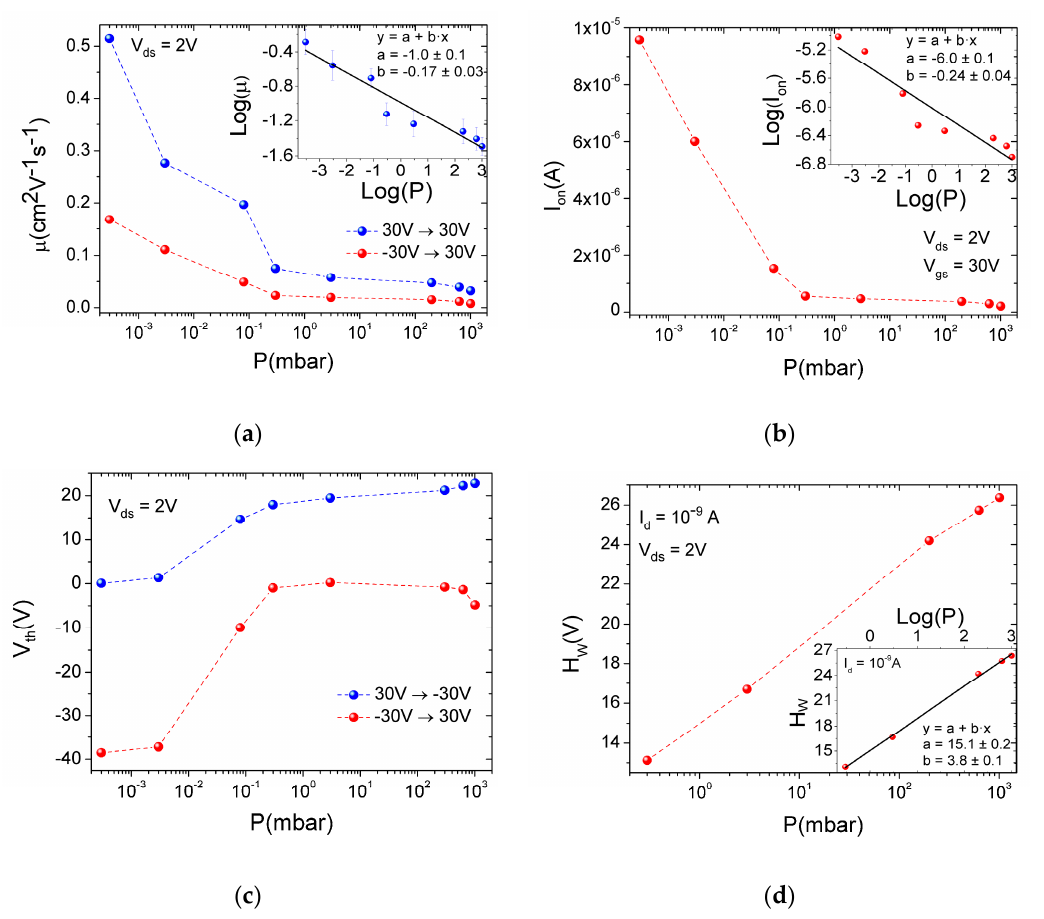
Figure 4. ( a ) Forward and reverse mobility as function of pressure. Linear fit of the data on log–log scale in the inset, ( b ) current in the on state as function of pressure. Linear fit of the data on log–log scale in inset, ( c ) forward and reverse threshold voltage as function of pressure, and ( d ) hysteresis width at I d = 1 nA versus air pressure. Linear fit of data on semi-log scale in the inset.